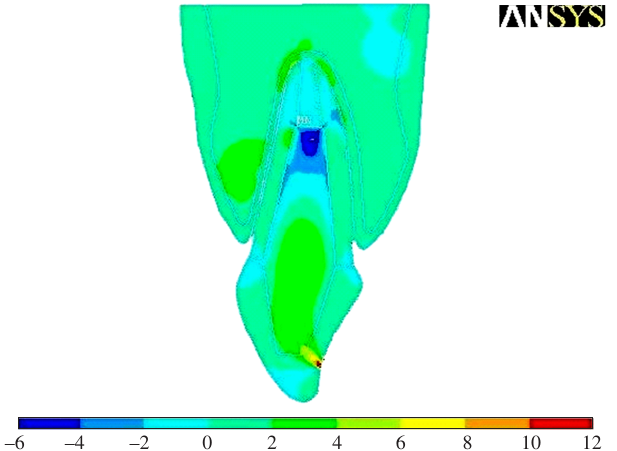
Figure 5. Shear stress (MPa) distribution in Model 2.